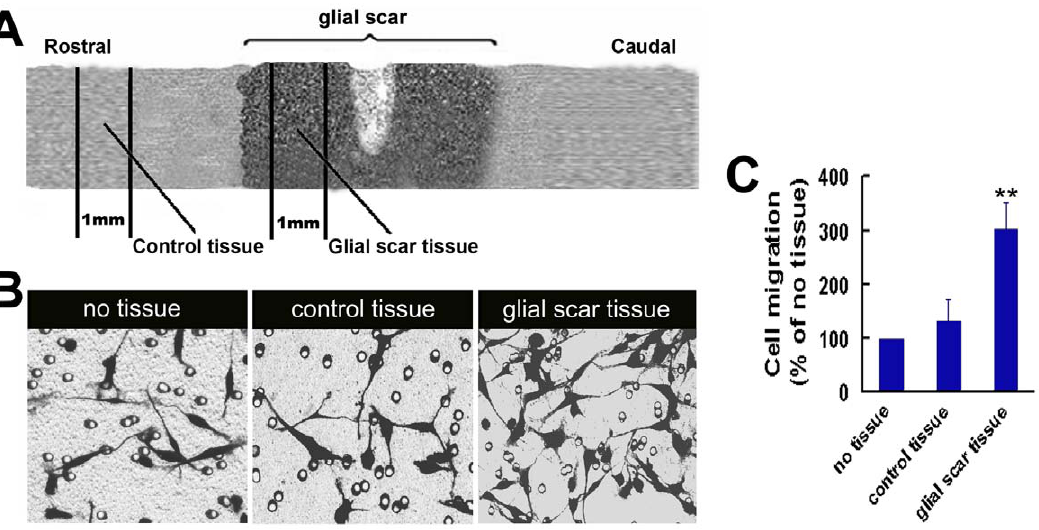
Figure 1. Analysis of the effect of glial scar tissue on OECs migration by a Boyden chamber migration assay. (A) Schematic representation of the control tissue and glial scar tissue prepared from injured spinal cord. Seven days after SCI, the spinal cord spanning lesion site was dissected and placed in Hank’s balanced salt solution. Glial scar tissue was prepared by cutting an approximately 1-mm-thick cross-section of spinal cord in the region of glial scar. Control tissue was prepared by cutting an approximately 1-mm-thick cross-section of spinal cord distal to the region of glial scar. The mobility of OECs was analyzed in a Boyden chamber migration assay. OECs were seeded onto the upper chamber at a density of 4 6 10 5 cells, with the spinal cord explants (control tissue or glial scar) plated into the lower chamber, and incubated 8 hr at 37 u C. (B) Photomicrograph of OECs transmigrated through the filter in the absence or presence of glial scar tissue. (C) Quantitative assessment of migrating cells under different conditions. ** P , 0.01 versus control tissue group.